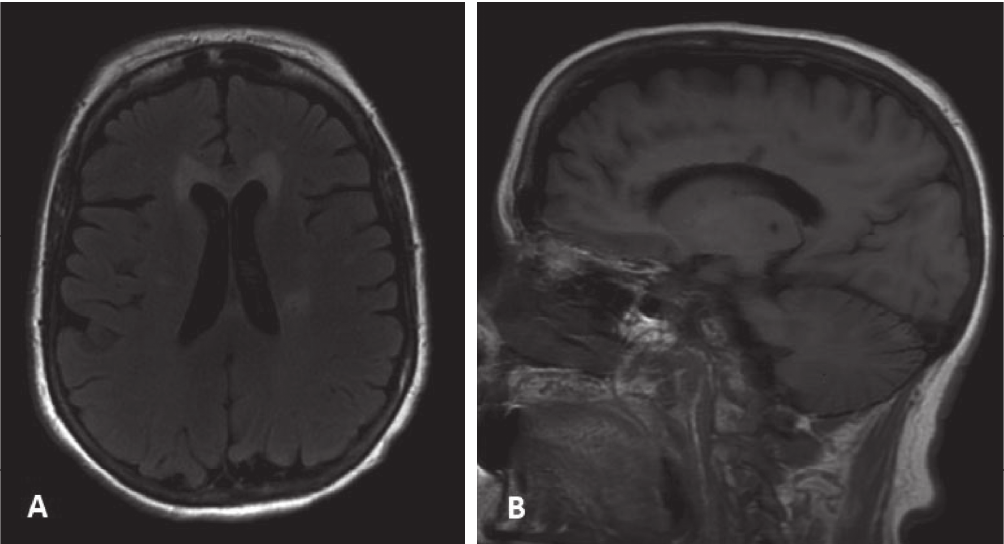
Figure 2: (a) An axial fluid-attenuated inversion recovery (FLAIR) sequence demonstrating a hyperintense lesion in the genu of the corpus callosum and smaller lesions, most notably in the left corona radiata area. (b) A sagittal T1-weighted image demonstrating a hypointense lesion in the genu and body of the corpus